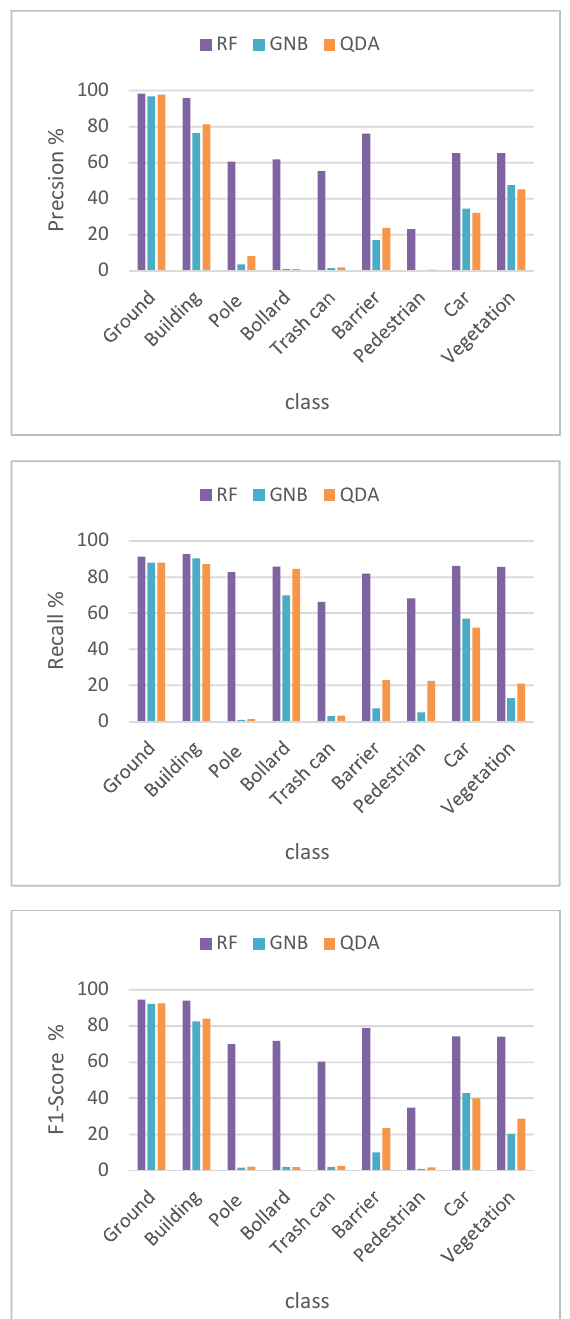
Figure 4. Precision, recall and f1-score of the three ML